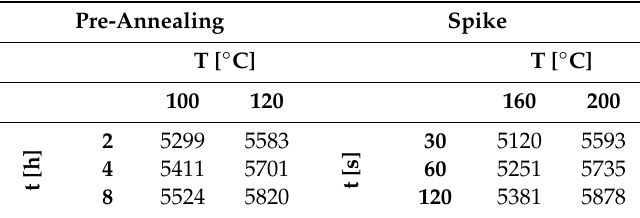
Table 3. Comparison of Larson-Miller parameters of pre-annealing and spike parameters. Values were calculated according to Larson-Miller parameters = T [K] * (log(time [h]) + C). Constant C was set to 13.9 for all calculations, according to Reference